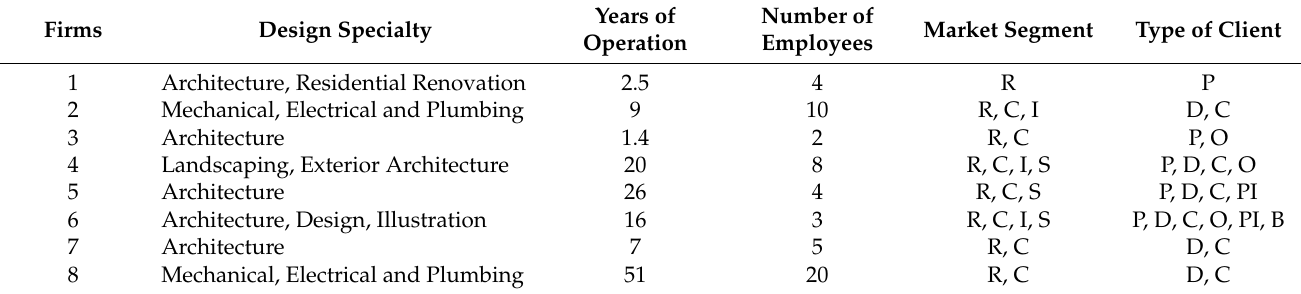
Table 1. AE design firms